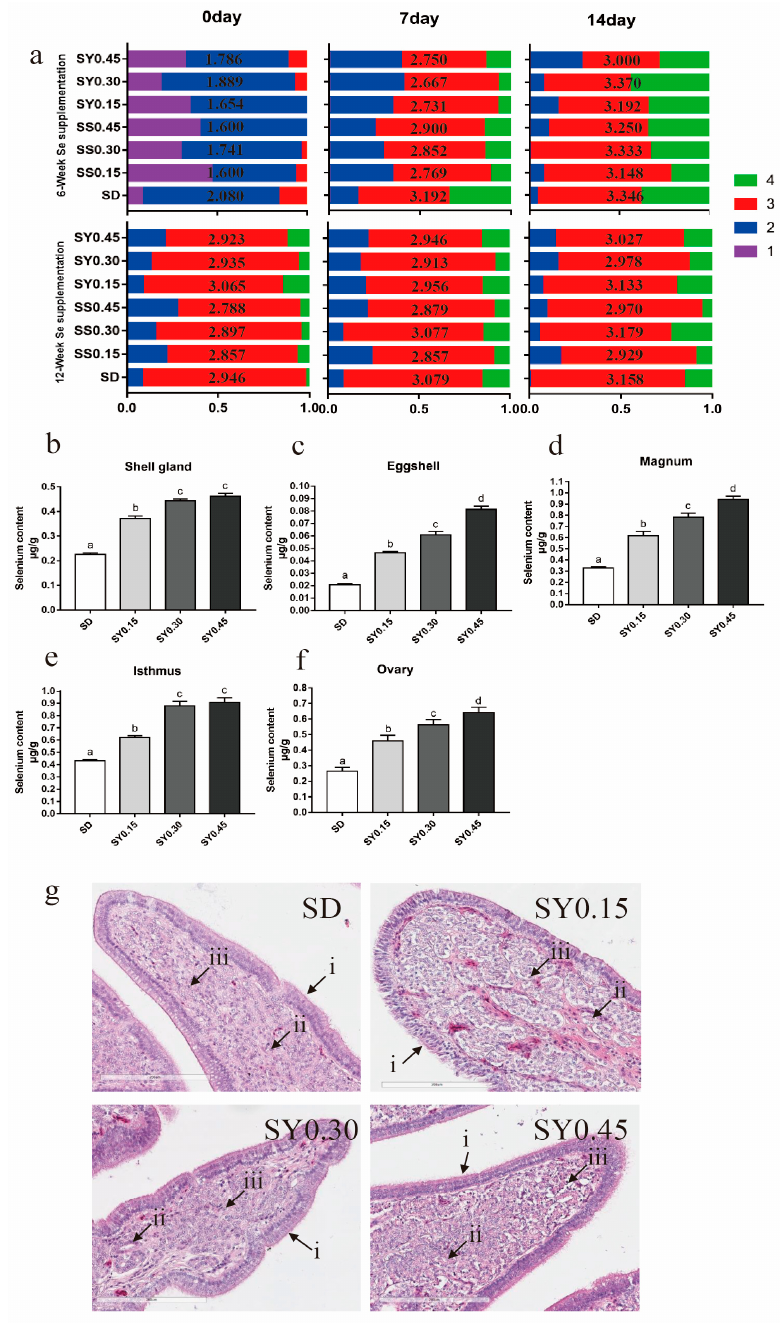
Figure 1. Eggshell quality and organs Se status in aged laying hens during the whole experiment period. ( a ) The changes of translucent eggs during selenium yeast supplementation, the average score is shown in the middle of the bar. The data in the horizontal row were detected on different days when eggs were stored; similarly, the data in the vertical row were detected in different weeks of age. ( b ) Selenium content in the shell gland after selenium yeast supplementation for 12 weeks. ( c ) Selenium content in eggshell after selenium yeast supplementation for 12 weeks. ( d ) Selenium content in magnum after selenium yeast supplementation for 12 weeks. ( e ) Selenium content in isthmus after selenium yeast supplementation for 12 weeks. ( f ) Selenium content in ovary after selenium yeast supplementation for 12 weeks. Data are expressed as mean ± SEM. Within each panel, means without a common letter differ at p < 0.05. ( g ) H&E staining of representative in shell gland after selenium yeast supplementation for 12 weeks (20 × ), (i) the mucosal epithelial cell layer, (ii) shell gland, (iii) lymphocyte. Scale bar = 200 µ